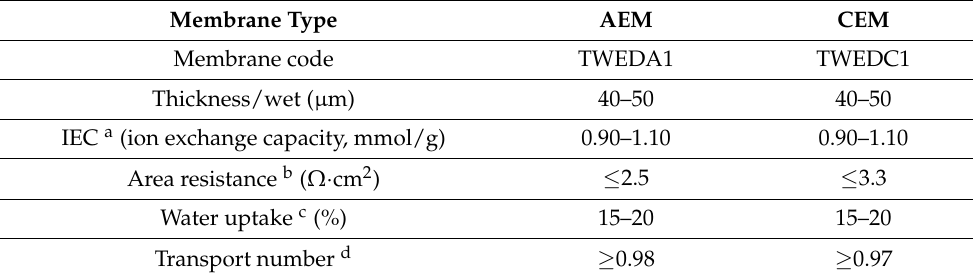
Table 2. The main characteristics of AEM and CEM used in this study.